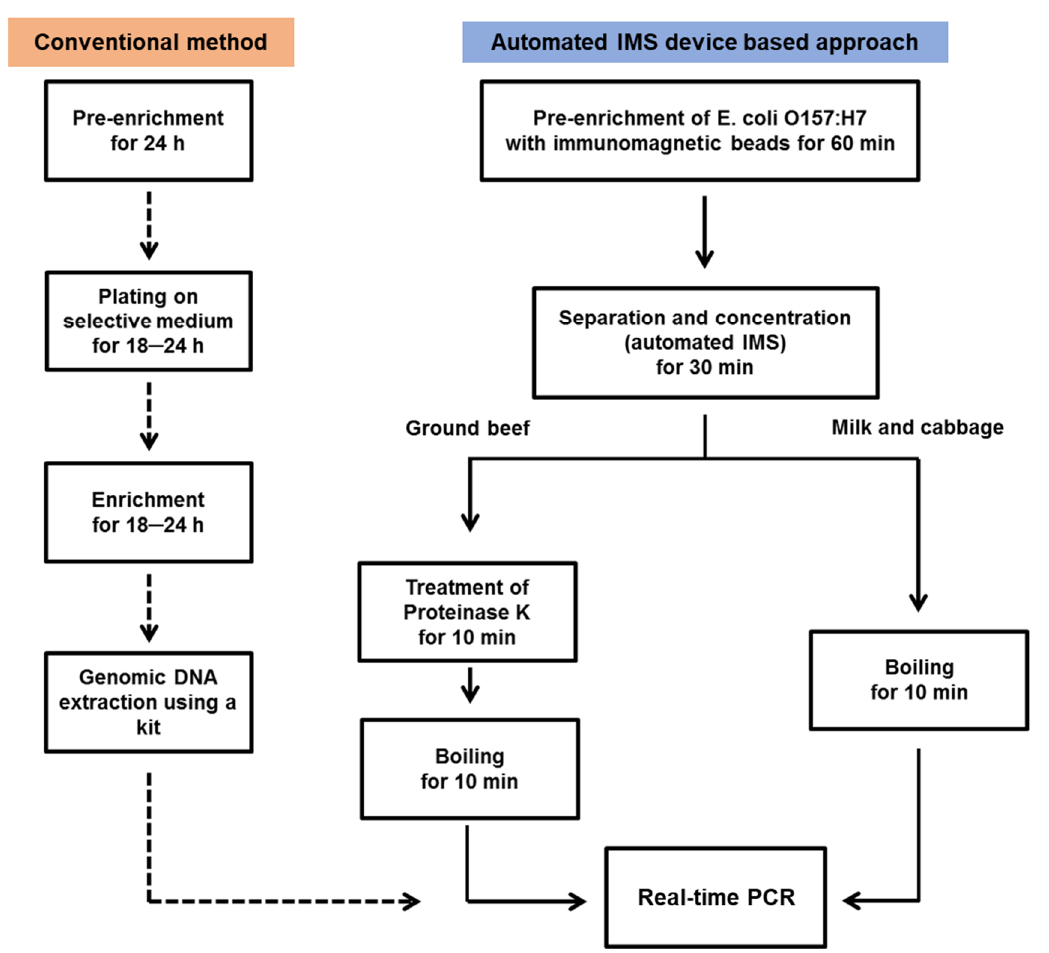
Figure 1. Procedure for the detection of target Escherichia coli O157:H7 in food samples. Contaminated